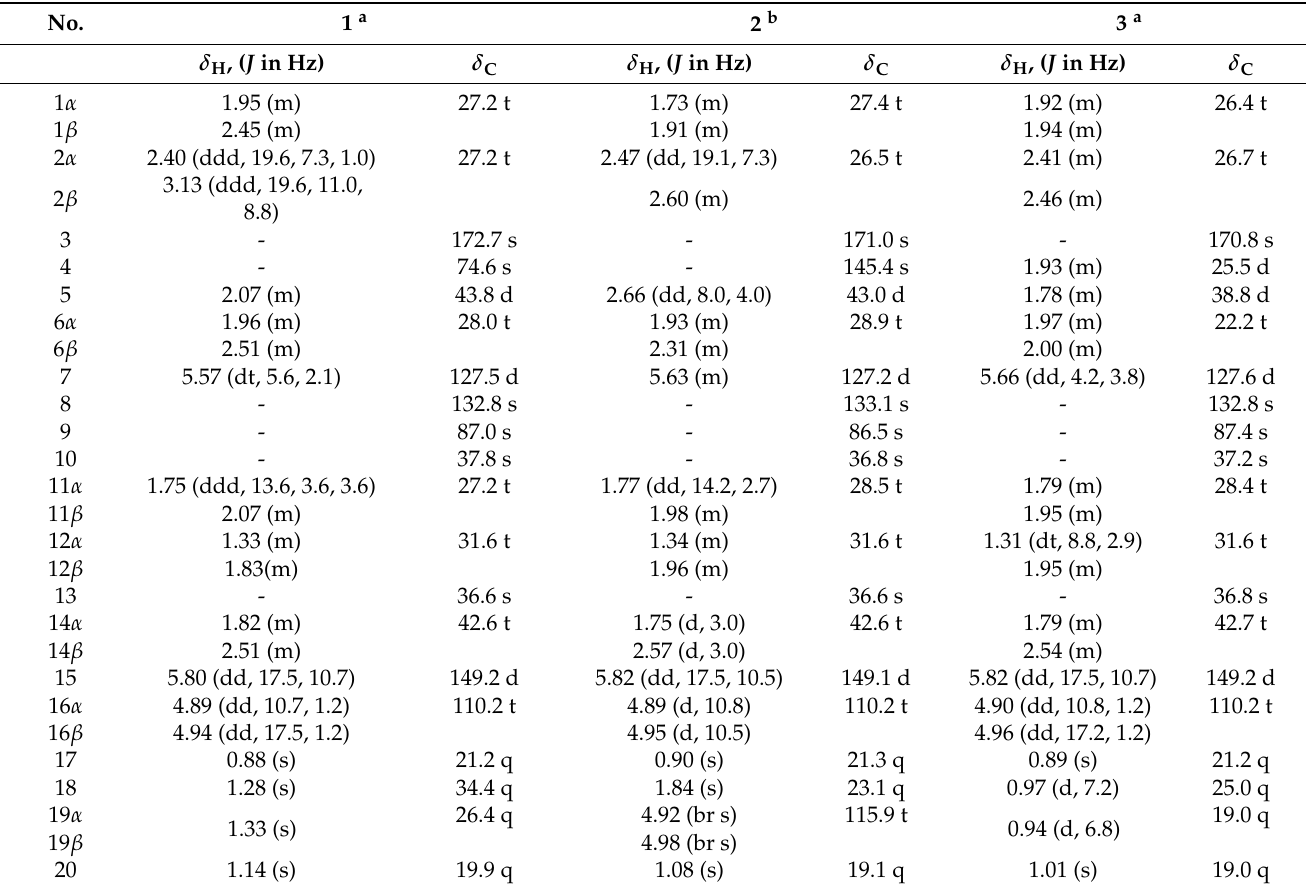
Table 1. 1 H and 13 C NMR spectral data ( J in Hz) of 1 – 3 in CDCl 3 .